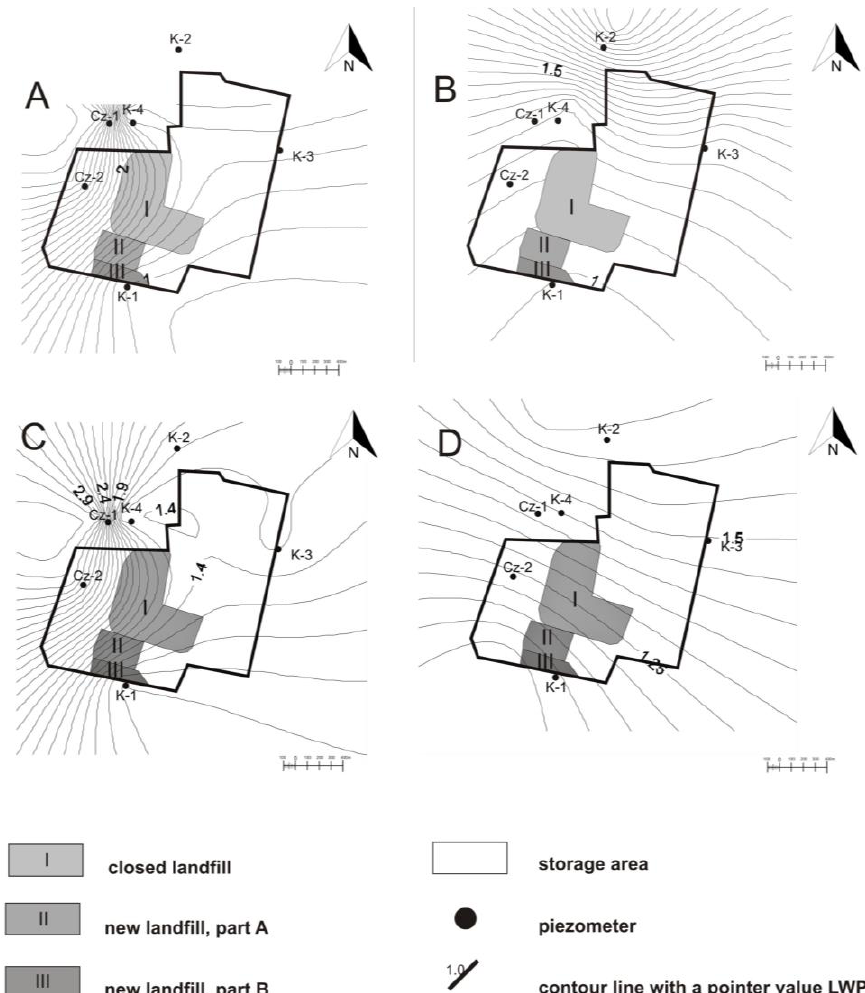
Fig. 2. Distribution of LWPI values in the studied area: A - for piezometers capturing the Quaternary and Jurassic aquifer; B - for piezometers capturing only the Jurassic